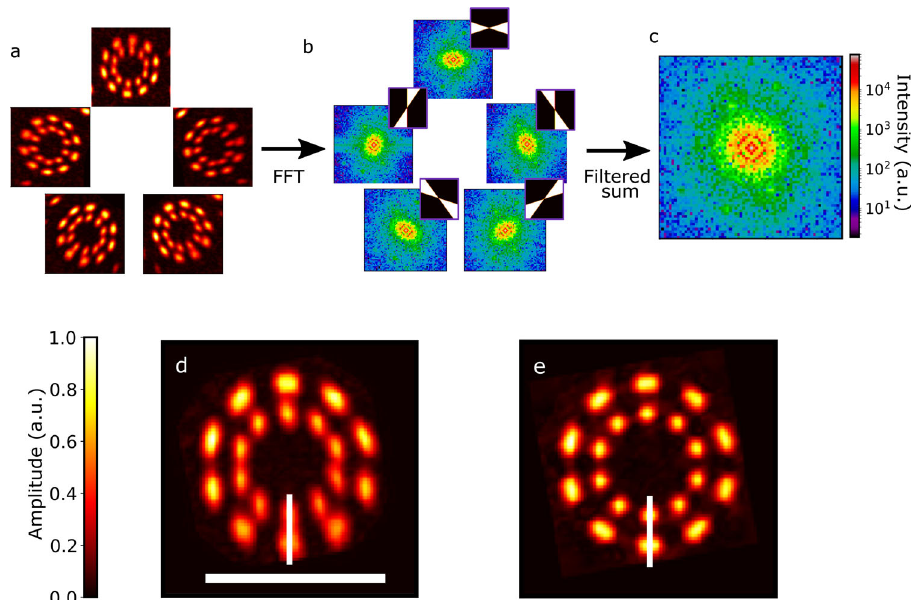
Fig. 3 Illustration of the broadband Fourier transform holography method. a Each cross-correlation term is transformed into Fourier space by applying an fast Fourier transform (FFT) ( b ), where a binary fi lter is applied (small inset), which preserves the high-resolution spatial frequencies. The spatial frequencies are summed and yield a high-resolution Fourier space image which is shown in c . d An enlarged smeared cross-correlation term before the broadband Fourier transform holography (FTH) method was applied and e shows the result of the broadband FTH method. The scalebar in d corresponds to 1 µ m and is shared for d and e . The amplitude and intensity is given in arbitrary units